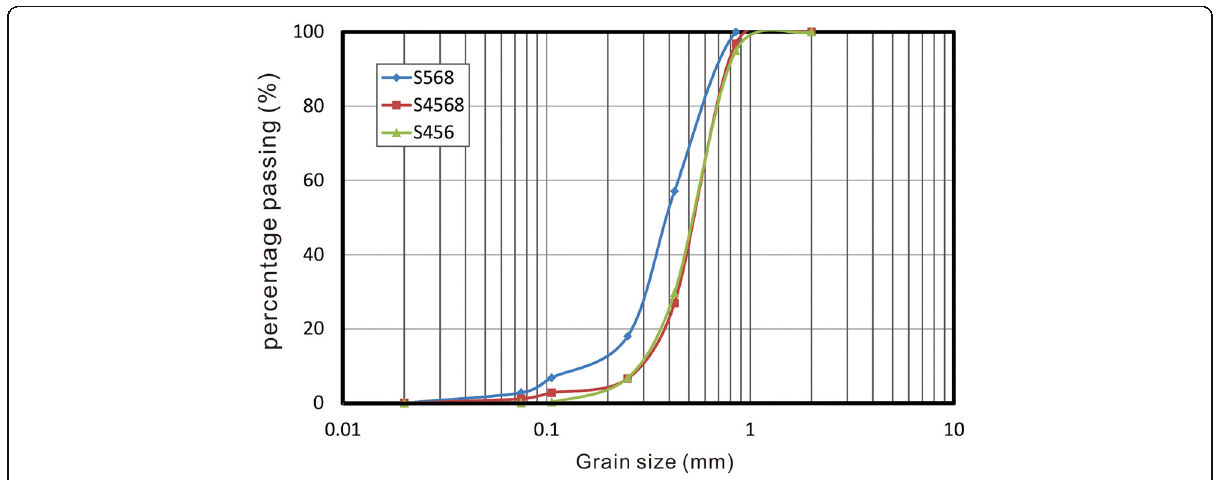
Fig. 2 Grain size distribution curves of samples used in experiments